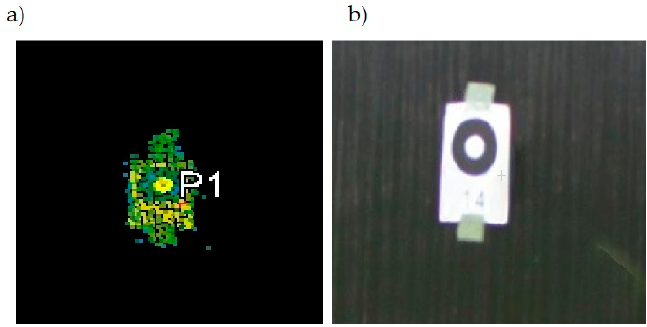
Figure 12 . The representation of control points ( a ) on a laser scanning view and ( b ) on images .